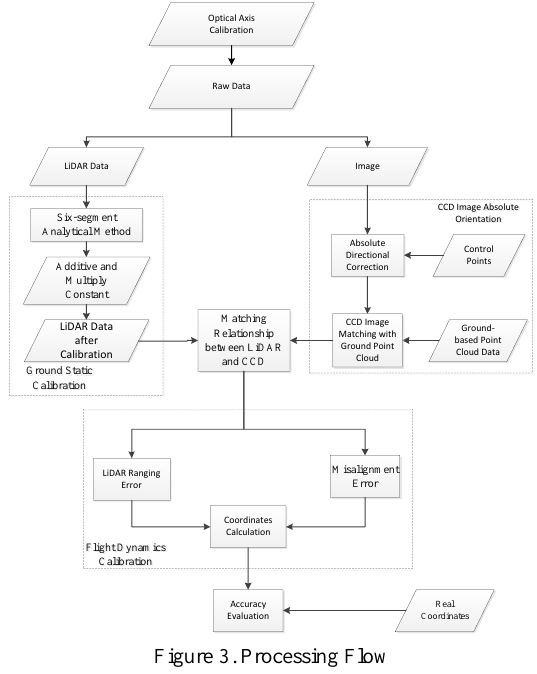
Figure 3. Processing Flow 3.1 Parallelism Calibration of Optical Axis Optical axis parallelism calibration is mainly based on indoor optical axis alignment debugging method of long-focus optical focal plane imaging. The main principle is that, for different parallel lights, with different angles between the light and optical axis, when the parallel light gets into the collimator, it will be focused on the different positions at focal plane. On the contrary, if the imaging facula of the optical light representing different sensor receives coincidence in the collimator focal plane, then the central axis of the sensors field of view are considered to be parallel. Then repeated the calibration to the other detectors (Zhang, 2015). The calibration system is shown in Figure 4.